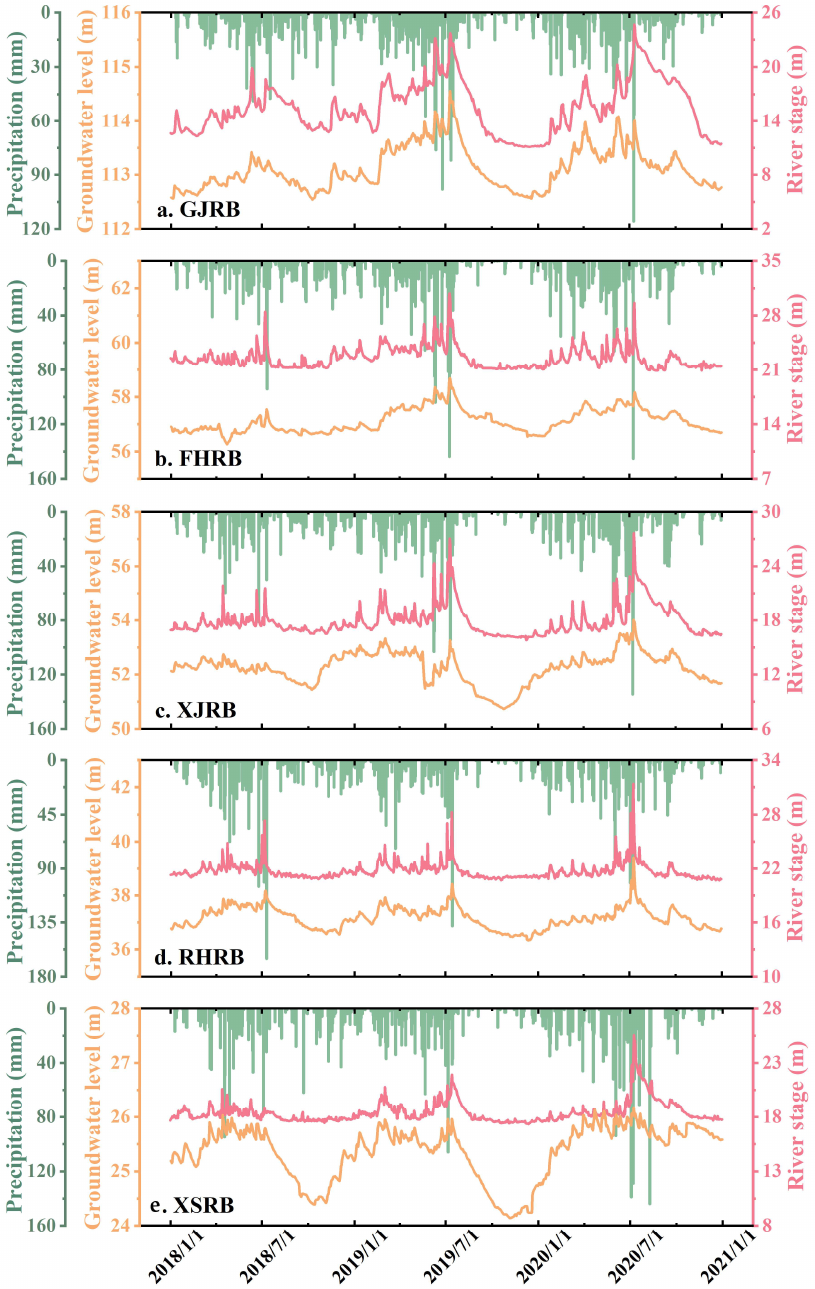
Figure 7. Groundwater level, river stage, and precipitation in sub-basins of the PLB from 2018 to 2020. ( a ) GJRB, ( b ) FHRB, ( c ) XJRB, ( d ) RHRB and ( e ) XSRB.